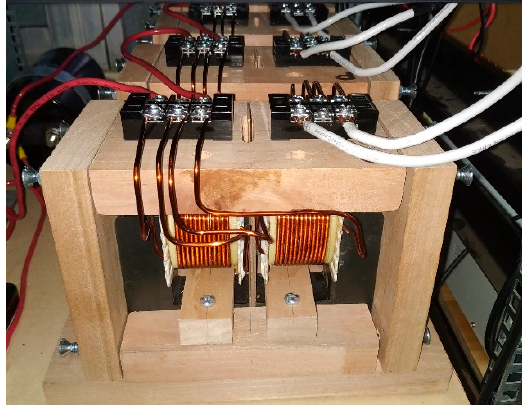
Figure 10. Ferrite core flyback transformers.